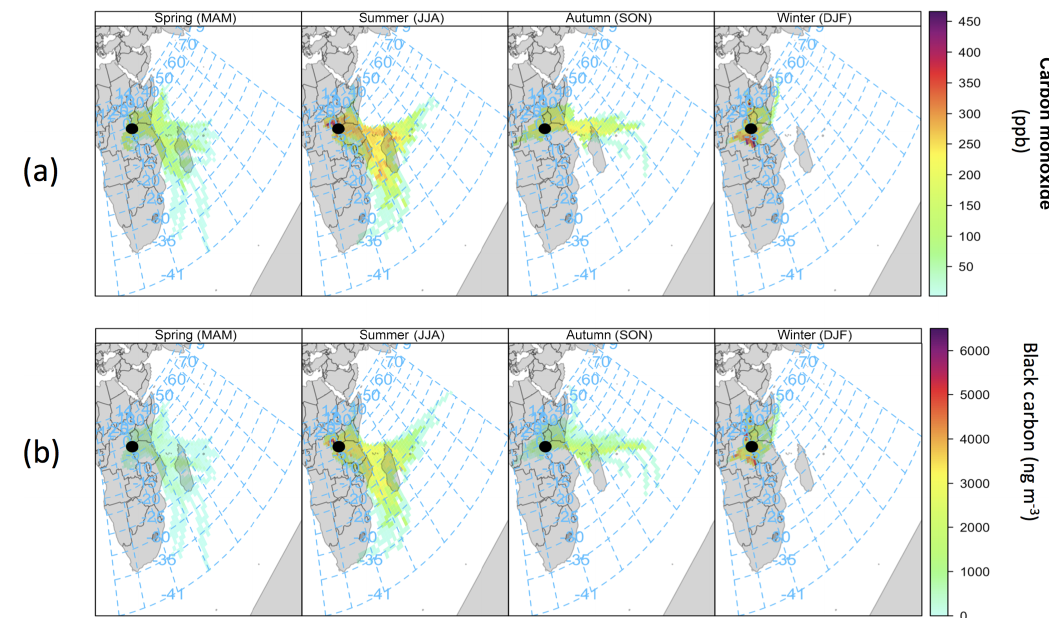
Figure 6. Concentration-weighted back trajectories of (a) CO and (b) BC, separated by season, for measurements at the Rwanda Climate Observatory (black dot) for the period of July 2015–January